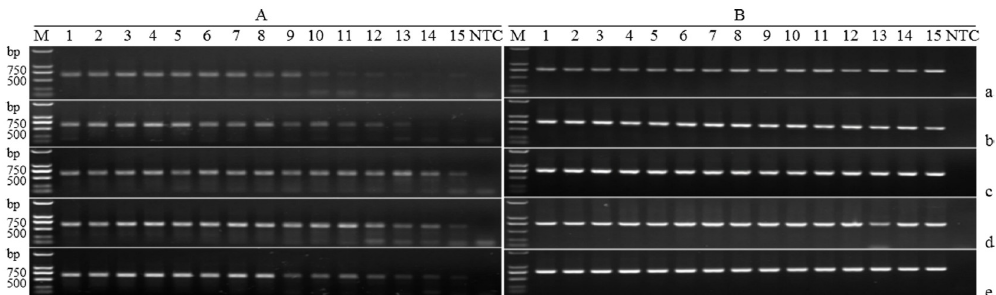
Fig 4. PCR amplification of the COI (A) and 28S (B) genes using a DNA template dilution series of fresh samples extracted using the SDS method. Five individuals of female adults are a-e. Lanes 1–15: 166.20 × 10 3 , 83.10 × 10 3 , 41.55 × 10 3 , 20.78 × 10 3 , 10.39 × 10 3 , 5.19 × 10 3 , 2.60 × 10 3 , 1.30 × 10 3 , 649.22, 324.61, 162.30, 81.15, 40.58, 20.29, 10.14 pg � μ L -1 , i . e ., 1-, 2-, 4-, 8-, 16-, 32-, 64-, 128-, 256-, 512-, 1,024-, 2,048-, 4,096-, 8,192-, and 16,384-fold dilutions, respectively. M: Trans2K DNA Marker; NTC: negative control (ultrapure